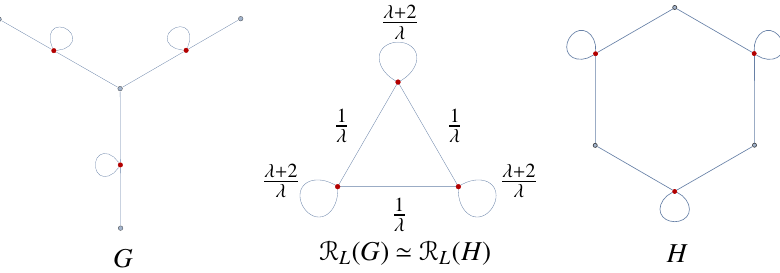
Fig. 9 The graph G and the graph H are spectrally equivalent with respect to the rule L that selects those vertices of a graph that have loops. In particular, the graphs R L ( G ) (cid:39) R L ( H ) are isomorphic as is